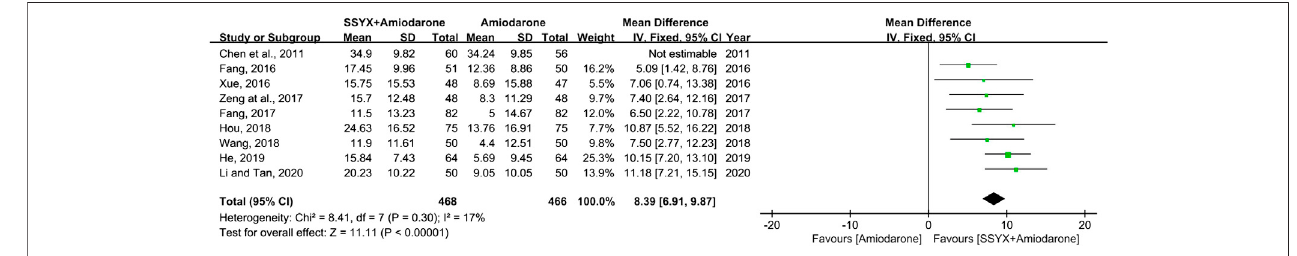
FIGURE 8 | Forest plot of comparison: SSYX-amiodarone vs. amiodarone alone: QTd.